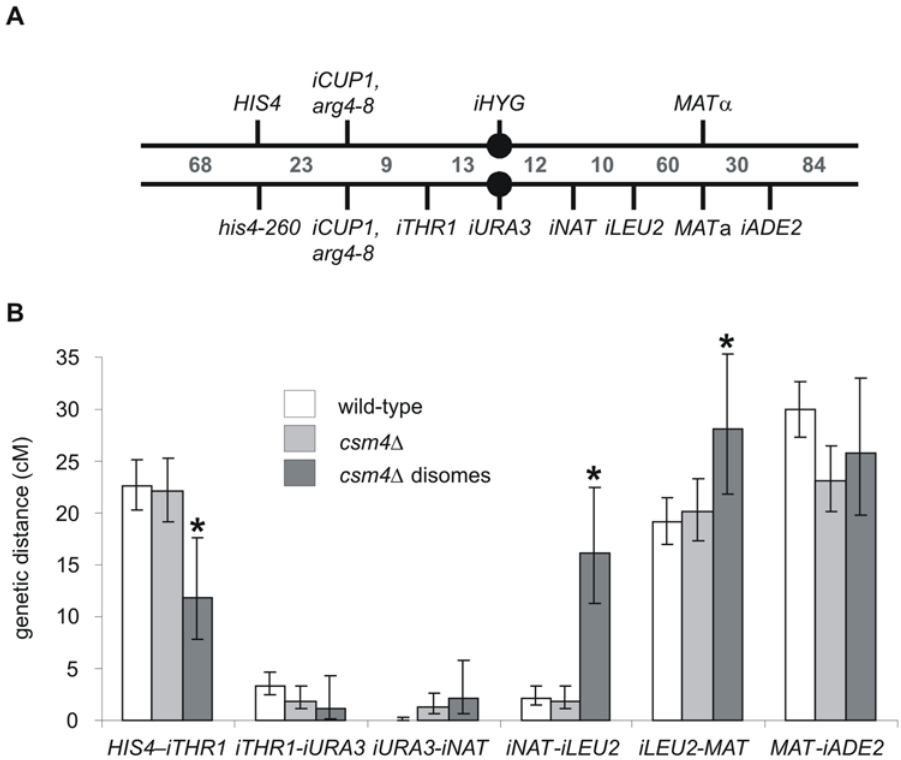
Figure 5. An altered distribution and frequency of crossovers is seen in csm4 D cells that have suffered a chromosome III nondisjunction event. A) Cartoon showing the chromosome III locus in the BR strain background (Materials and Methods). B) Graphical representation of recombination for WT and csm4 D tetrads and csm4 D disomic spores (from data in Table S4). Error bars indicate 95% confidence intervals around the recombination frequency determined from single spores, calculated using VassarStats (http://faculty.vassar.edu/lowry/ VassarStats.html). ‘‘i’’ indicates insertion of the indicated marker at an ectopic locus. Recombination frequencies obtained from single spore data were multiplied by 100 to yield genetic map distances (cM). * csm4 D disomic recombination levels are significantly different (G-test, p , 0.025, Dunn-Sidak correction) from the csm4 D tetrad data.